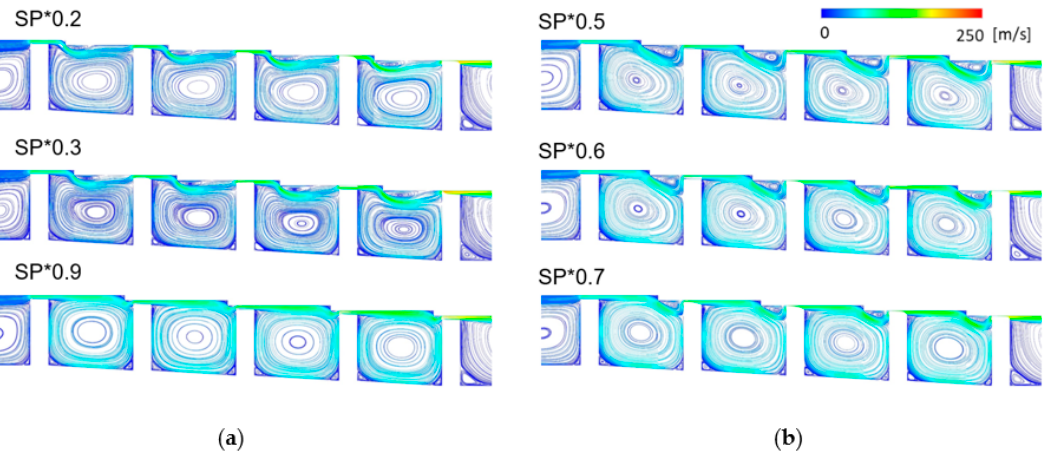
Figure 10. Change in the cavity flow structure according to SP. ( a ) High ‐ discharge ‐ coefficient group. ( b ) Low ‐ discharge ‐ coefficient group.